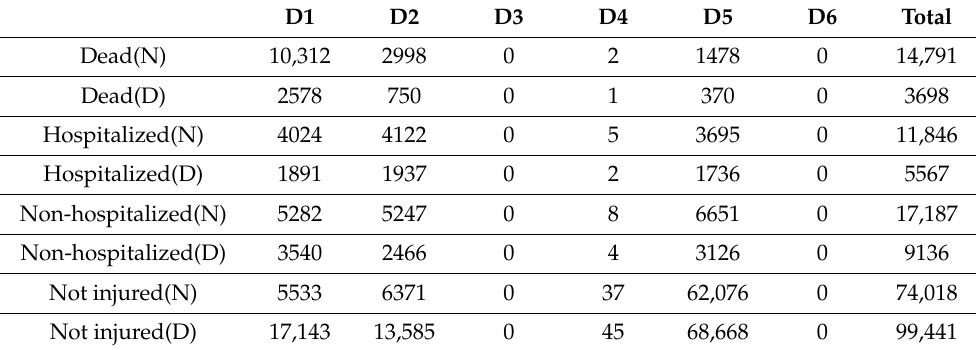
Table 16. Number of casualties in the 1721 earthquake in District 7 of Tabriz.